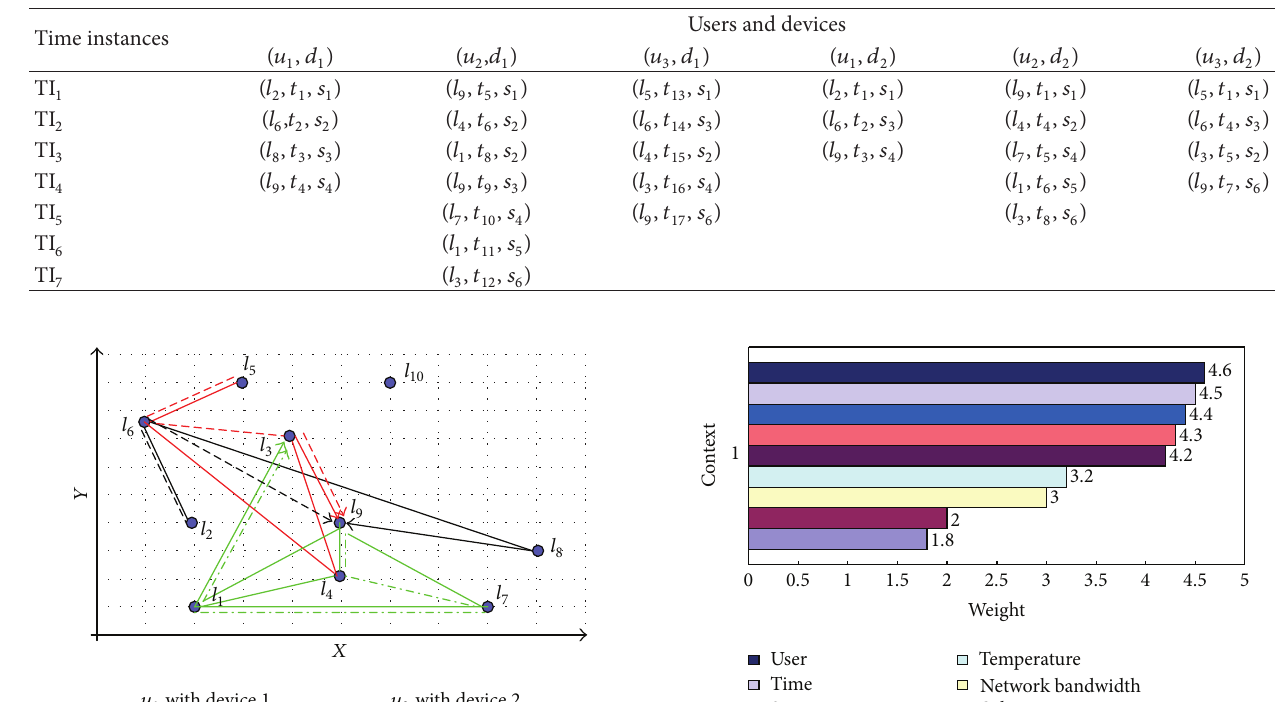
Table 1: Customer service information table.